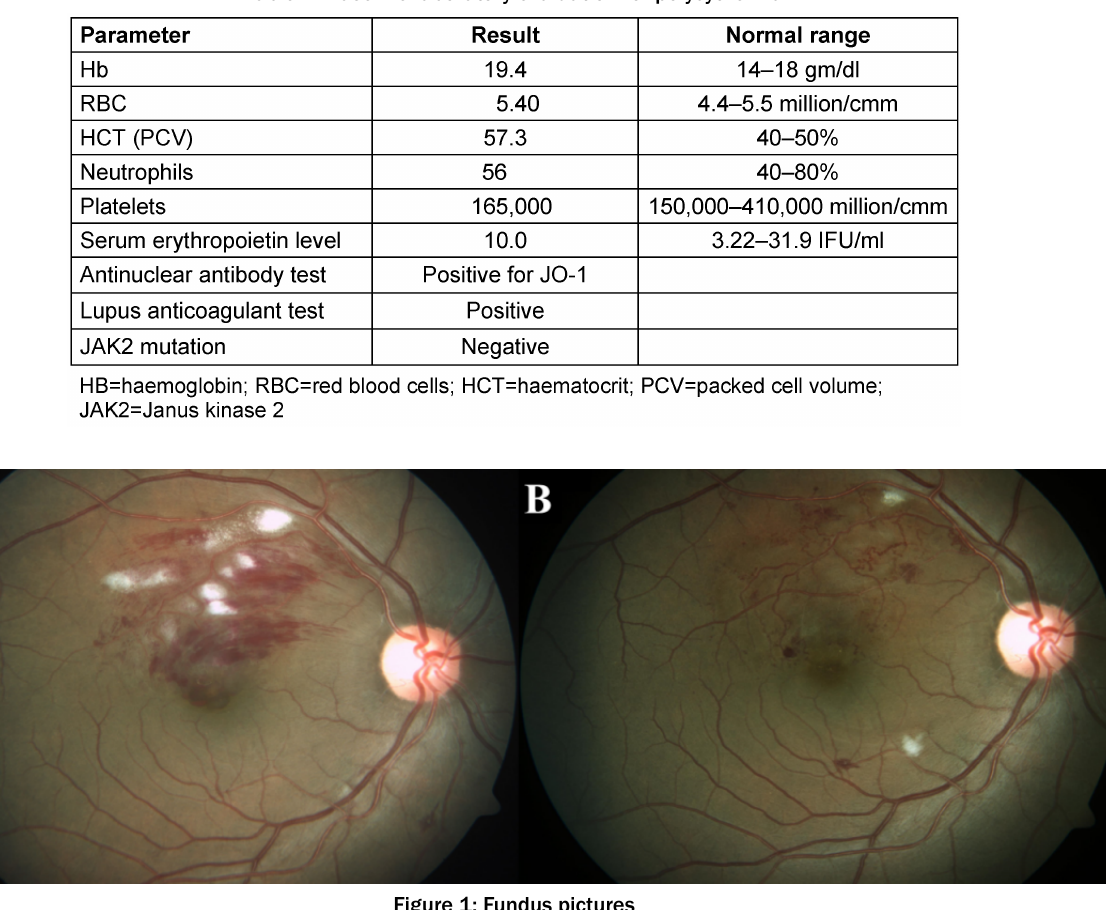
Table 1: Baseline laboratory evaluation for polycythemia